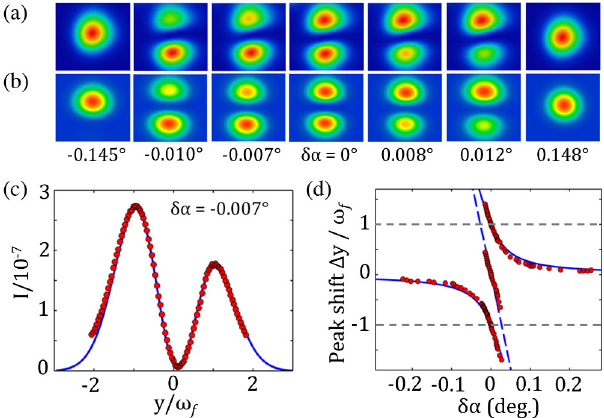
FIG. 4. s -polarized beam reflected off a silver mirror. Measured (a) and simulated (b) evolution of the modal confocal imaging mapping through maximum extinction (c) for different analyzer angles δα as explained in the text. In (d), the positions of the intensity extrema are shown in units of beam waist ω f at polarization in Fig. 2 (lower row) and always above and below the plane of incidence.